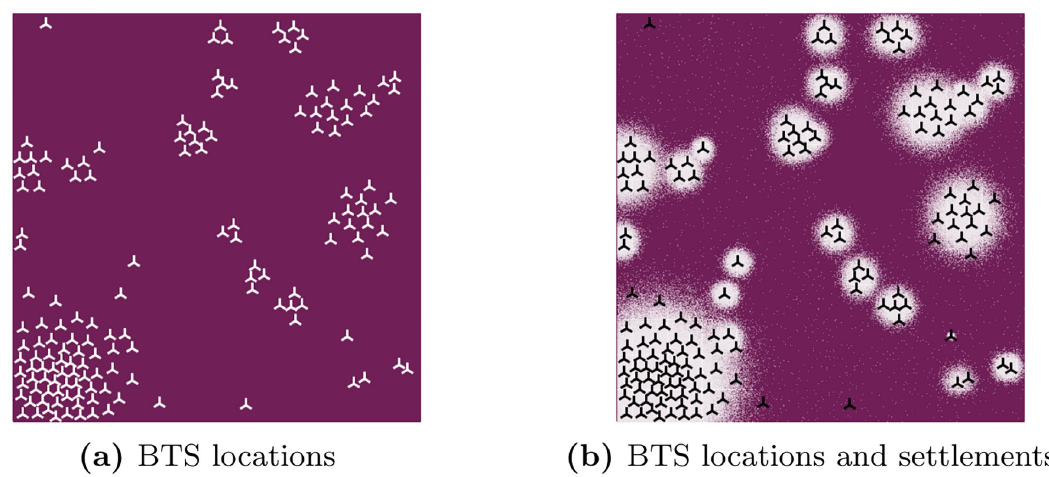
Fig 5. Simulation setup—BTS